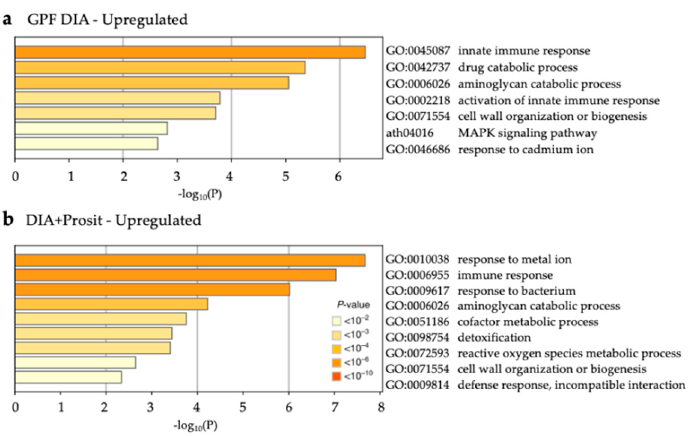
Figure 9. Increased GO biological processes and KEGG pathways during Xf infection in V. vinifera . Non-redundant enriched ontology clusters of significantly expressed proteins increased during Xf infection ( p < 0.05) in the ( a ) GPF DIA and ( b ) DIA + Prosit data sets. DIA + Prosit identified more pathways that were likely involved with plant response to bacteria.